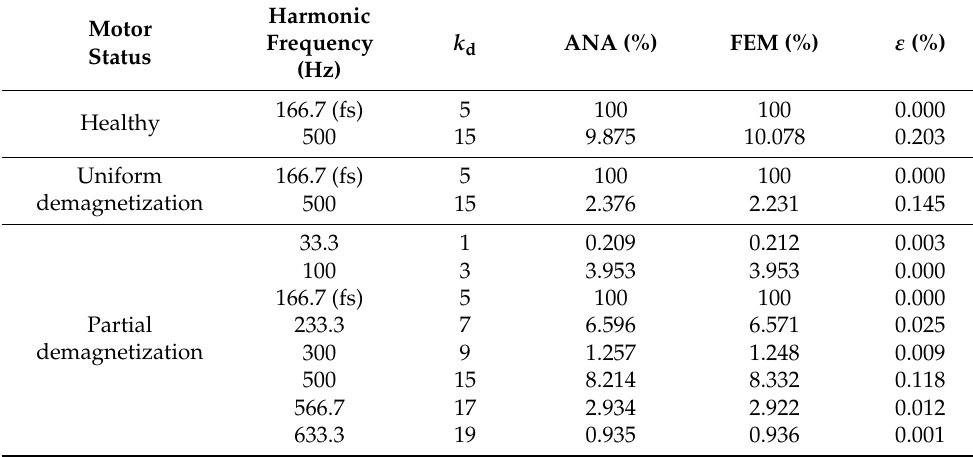
Table 2. Comparison of harmonic components of back-EMF and error.